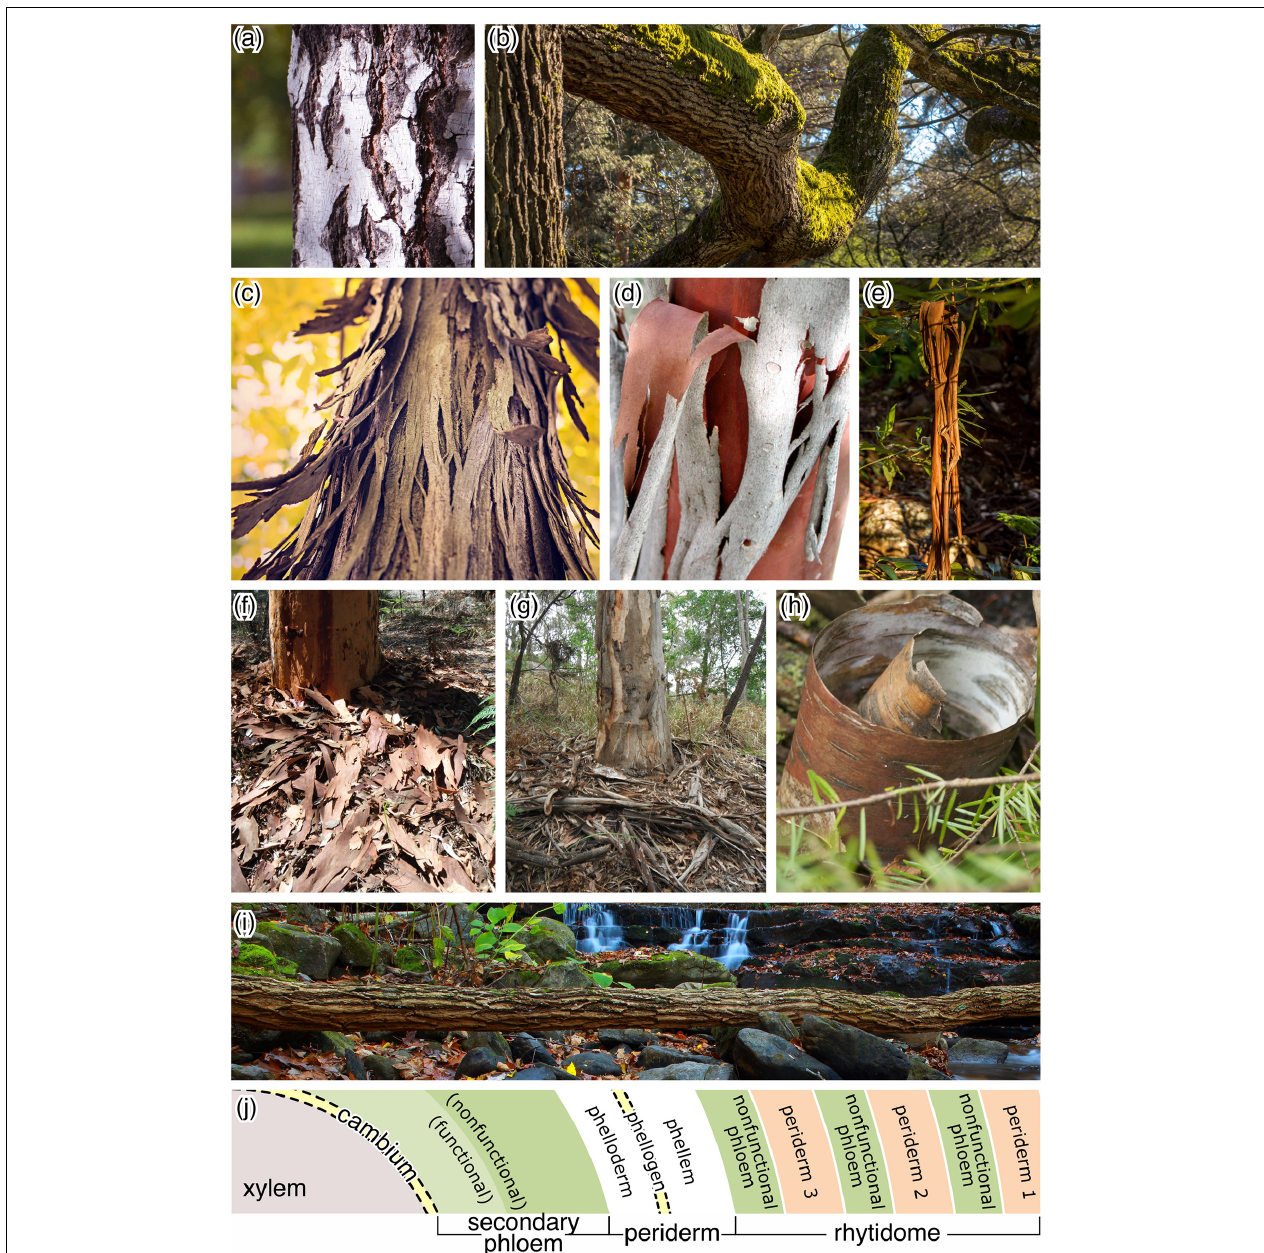
FIGURE 1 | Bark is present throughout a forest – beyond tree (a) stems and (b) branches. Bark shedding can (c,d) temporarily increase on-stem bark surface area, (e) release peelings that become trapped in understory canopies, and (f–h) cover the forest floor. Bark must also be broken down on (i) fallen dead trees. (j) Anatomy of the inner and outer bark. All photographs from open source databases (e.g., Pixabay, Wikimedia Commons) unless credited otherwise. Credits: (a) Tatyana Fyodorova; (b) Thomas B. Didgeman; (c) Ryan McGuire; (d) Niel Sperry; (e) Sandid (Pixabay); (f,g) permission from Saskia Grootemaat; (h) Justin Leonard; (i) Troy